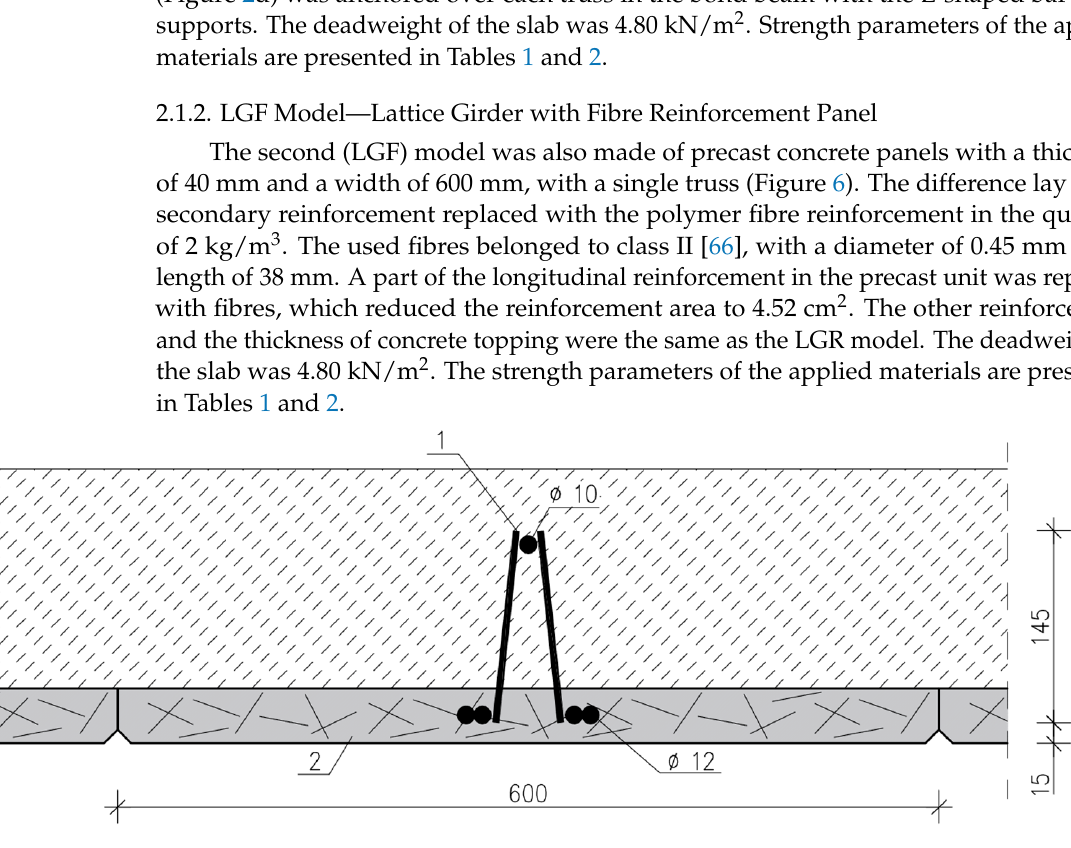
Figure 6. Cross-section of the slab with LGF panels: 1—lattice girder and 2—bottom plate with fibre reinforcement.